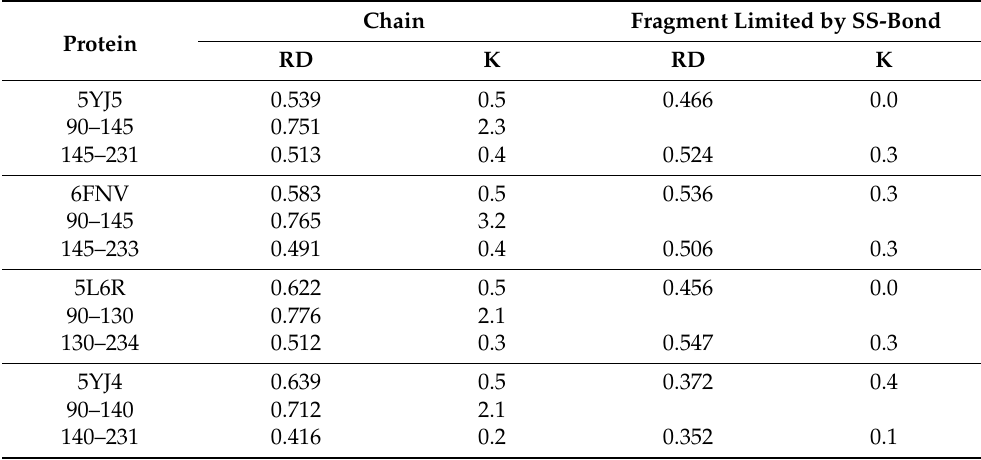
Table 2. Summary of the values of parameters RD and K describing the status of partially unfolded prion proteins (the values for the indicated sections are